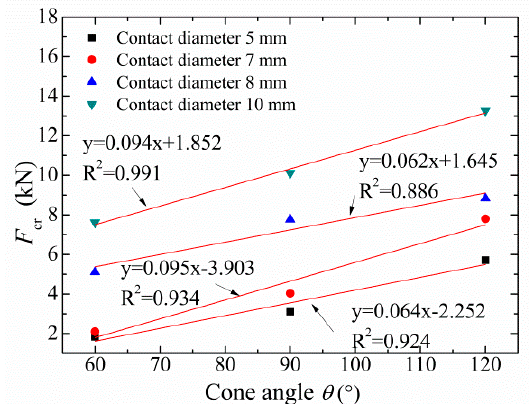
Figure 13. Relationships between critical normal force F cr and θ for particles of sphere diameter of 50 mm.